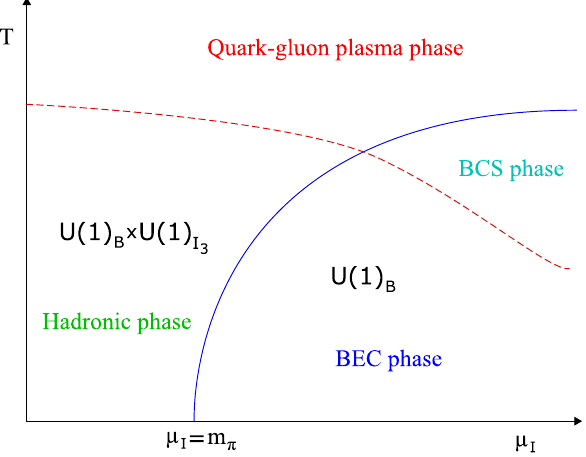
Fig. 1 Schematic phase diagram in the μ I – T plane. See main text for